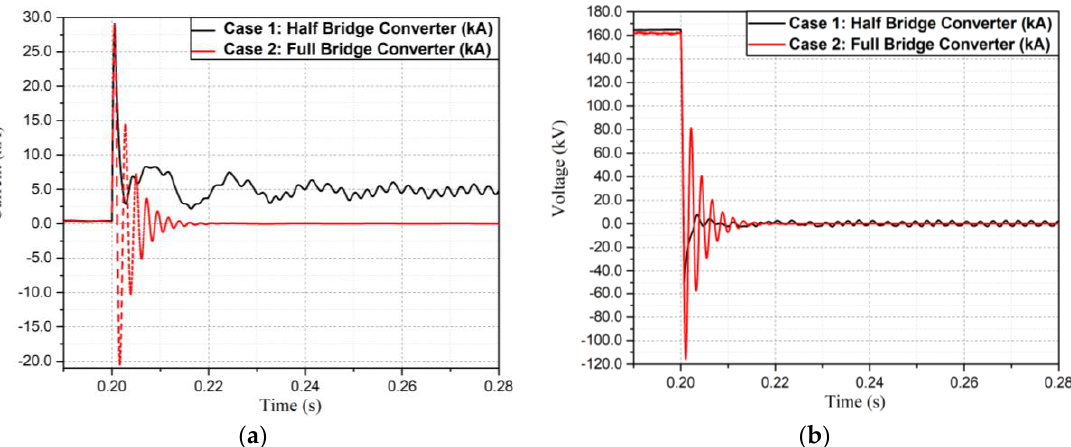
Figure 6. Simulation of a DC pole-to-pole fault with MMCs: (a) current waveform in the transient state; (b) voltage waveform in the transient state.